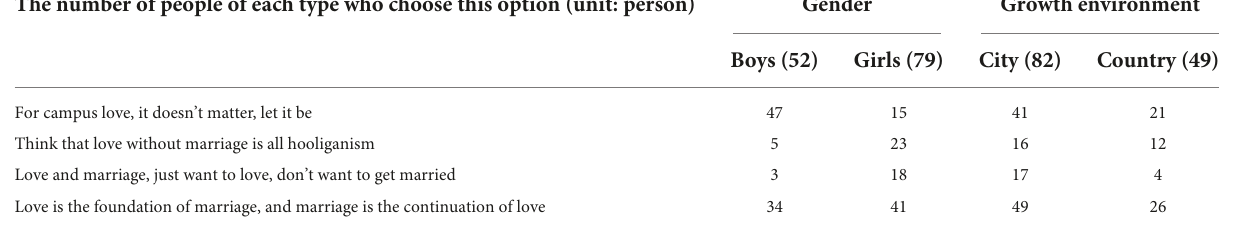
TABLE 10 Intra group comparison data of college students from divorced families in love outlook. The number of people of each type who choose this option (unit: person)